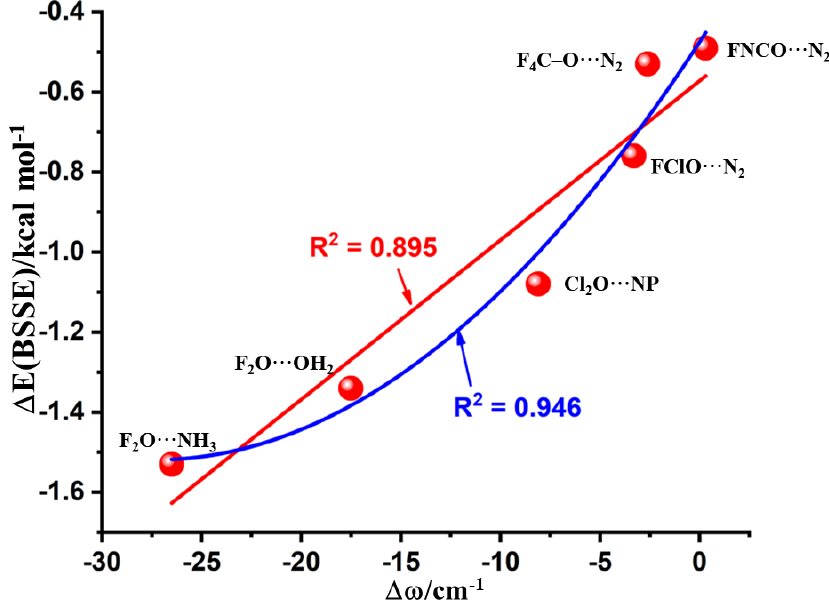
Figure 6. Dependence of the MP2/aug-cc-pVTZ level basis set superposition error energies (BSSE) corrected binding energy, ∆ E(BSSE) , on the shift in the vibrational frequency associated with the chalcogen donor bond for all the six binary complexes. The red and blue lines represent the data fitted to the linear and quadratic equations, respectively.